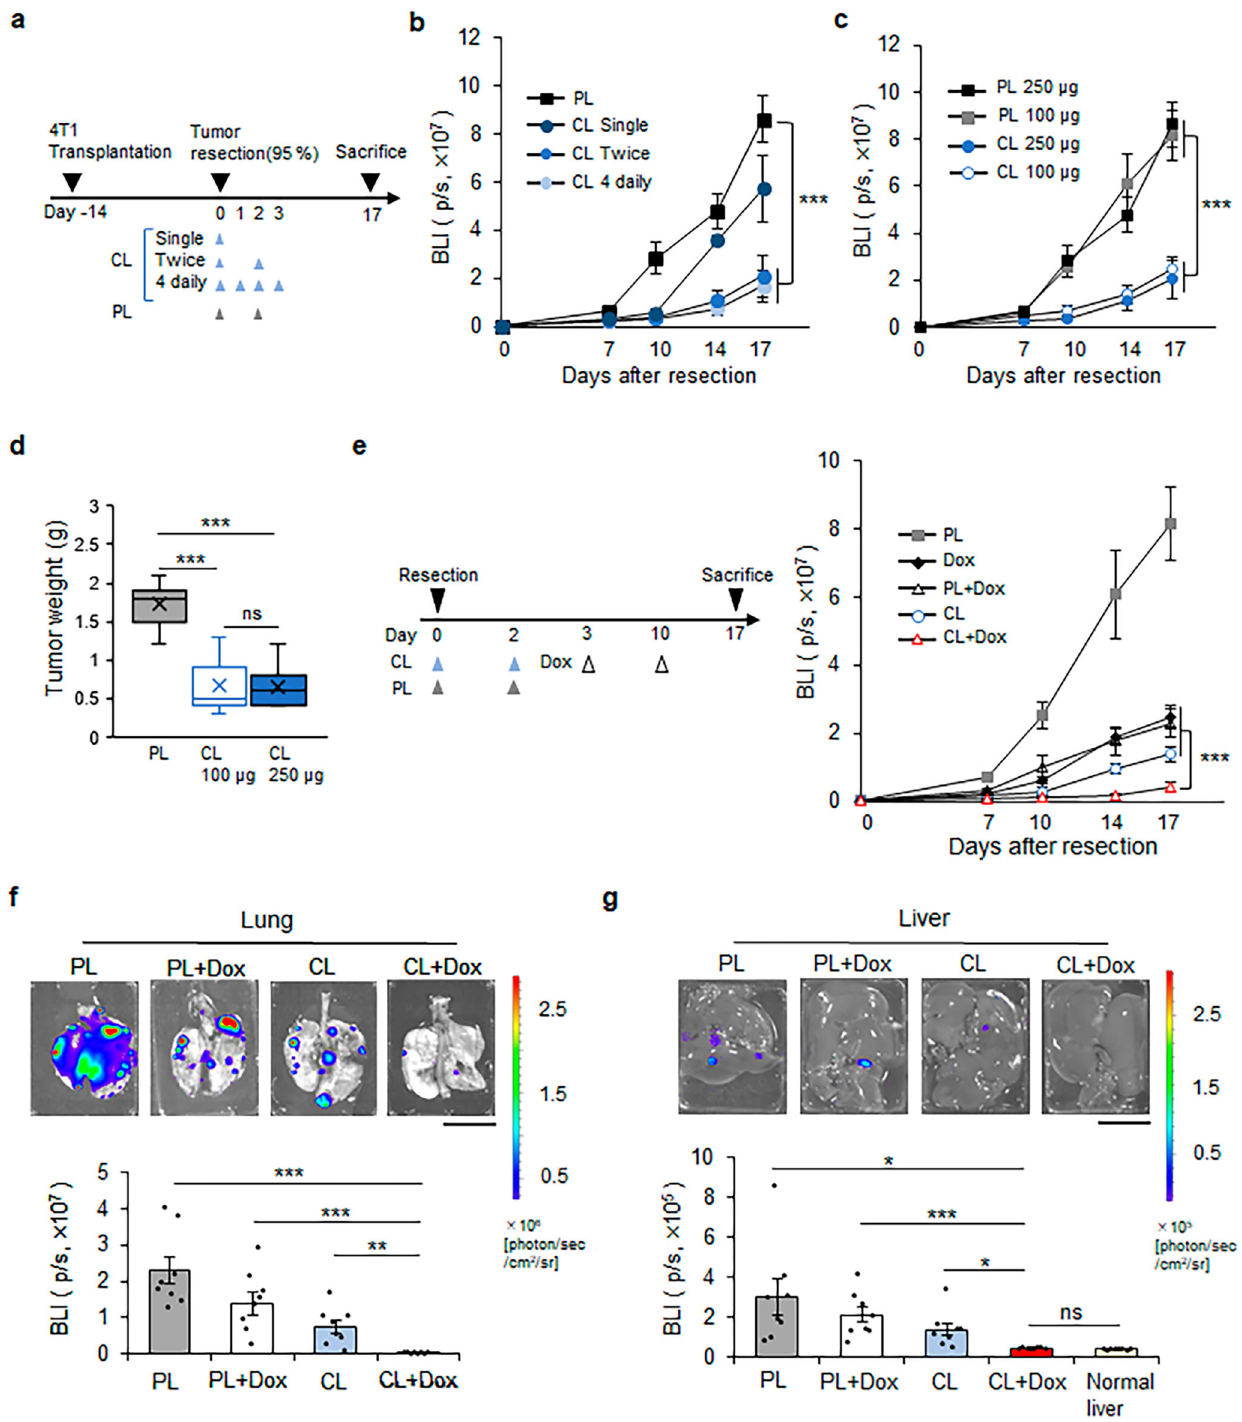
Fig. 5 Depletion of MGTRMs suppresses the local recurrence and distal metastasis of TNBC. a Diagram of work fl ow. 4T1 tumors were transplanted, resected, and treated with PL or CL administered topically to the tumor resection sites on the day of surgery (single), on the day of surgery and 2 days after surgery (twice), and for 4 consecutive days from the day of surgery (4 daily). b Bioluminescence signal from the 4T1 tumors left unresected was monitored after tumor resection, and treated with 250 µ g PL or CL as indicated in ( a ). n = 8. c Bioluminescence signal of the 4T1 tumors left unresected was monitored after tumor resection and administration of CL (250 µ g, 100 µ g), or PL (250 µ g, 100 µ g) at the resection sites on the day of surgery and 2 days after surgery. n = 8. d Box-and-whisker plot of weight of recurrent 4T1 tumors treated “ twice ” with PL or CL at the endpoint (day 17). Center line: median, box limits: upper and lower quartiles, whiskers: 1.5× interquartile range. n = 7. e After tumor resection, PL and CL were injected at the resection sites and doxorubicin (Dox) was administered intraperitoneally at indicated days (left), and the bioluminescence signal of the 4T1 tumors left unresected was monitored (right). n = 8. f , g Representative images (top) and bioluminescence signals (bottom) of the lung ( f ) and liver ( g ) from the mice shown in ( e ) at the endpoint (day 17). n = 8. Scale bar = 1 cm. b – g ns not signi fi cant, * p < 0.05, ** p < 0.01, *** p < 0.001 ( t -test). b , c , e – g Error bars indicate s.e.m.